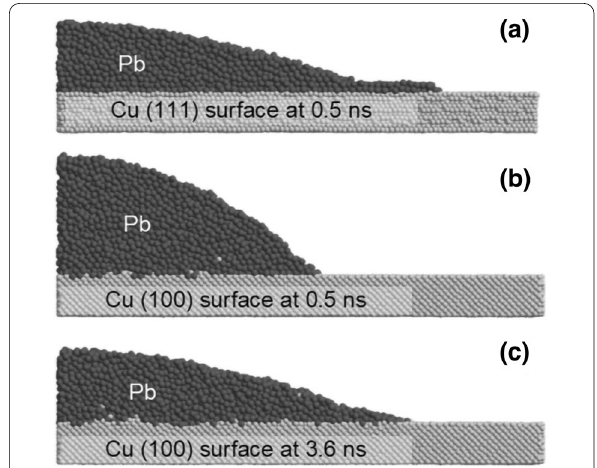
Figure 2 Snapshots from simulations of Pb on Cu surface: ( a ) Pb on Cu (111) surface at 0.5 ns, ( b ) Pb on Cu (100) surface at 0.5 ns, ( c ) Pb on Cu (100) surface at 3.6 ns